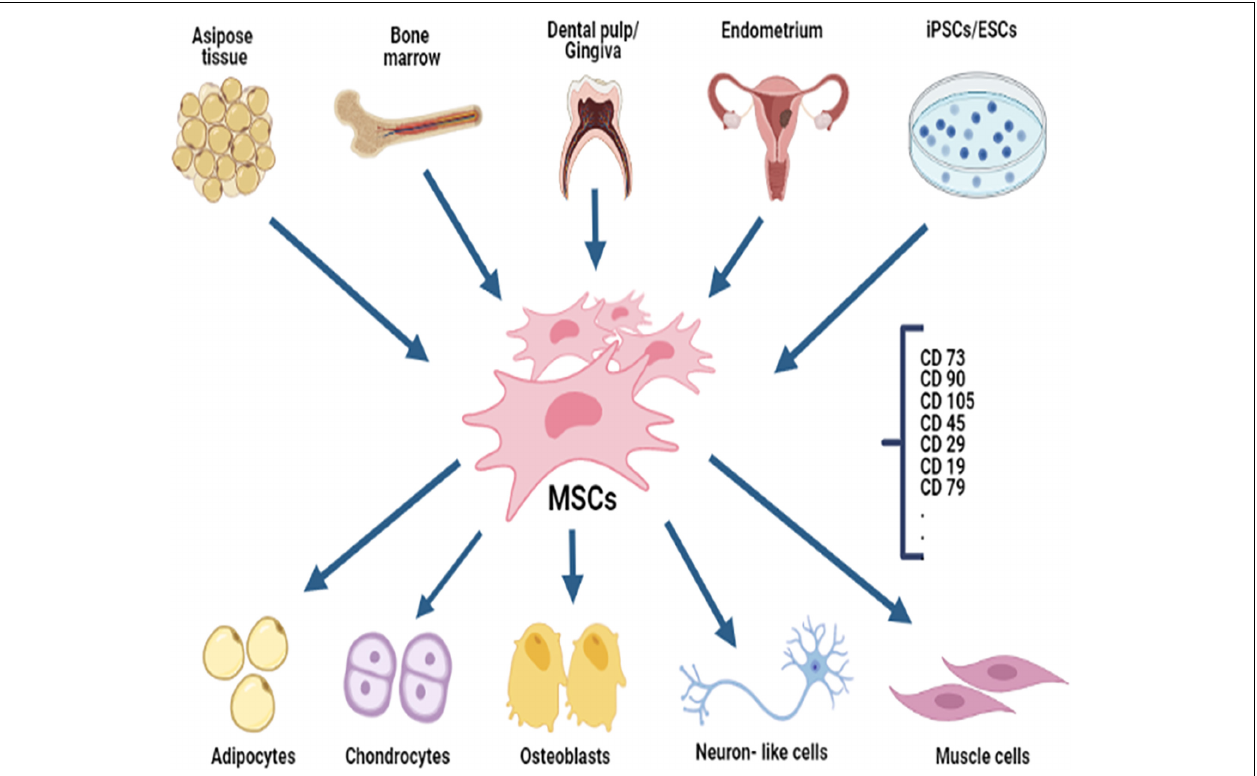
Frontiers in Cell and Developmental Biology |